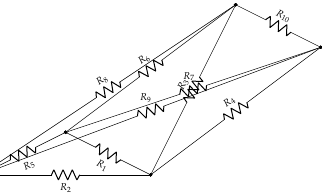
Figure 18. A multi-connected resistive grid from Figure 17b.